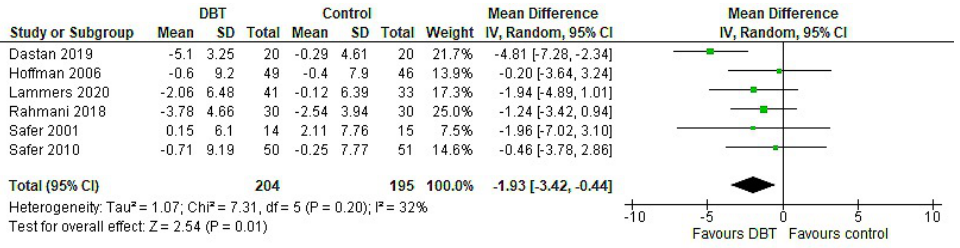
Figure 7. Forest plot: analysis of